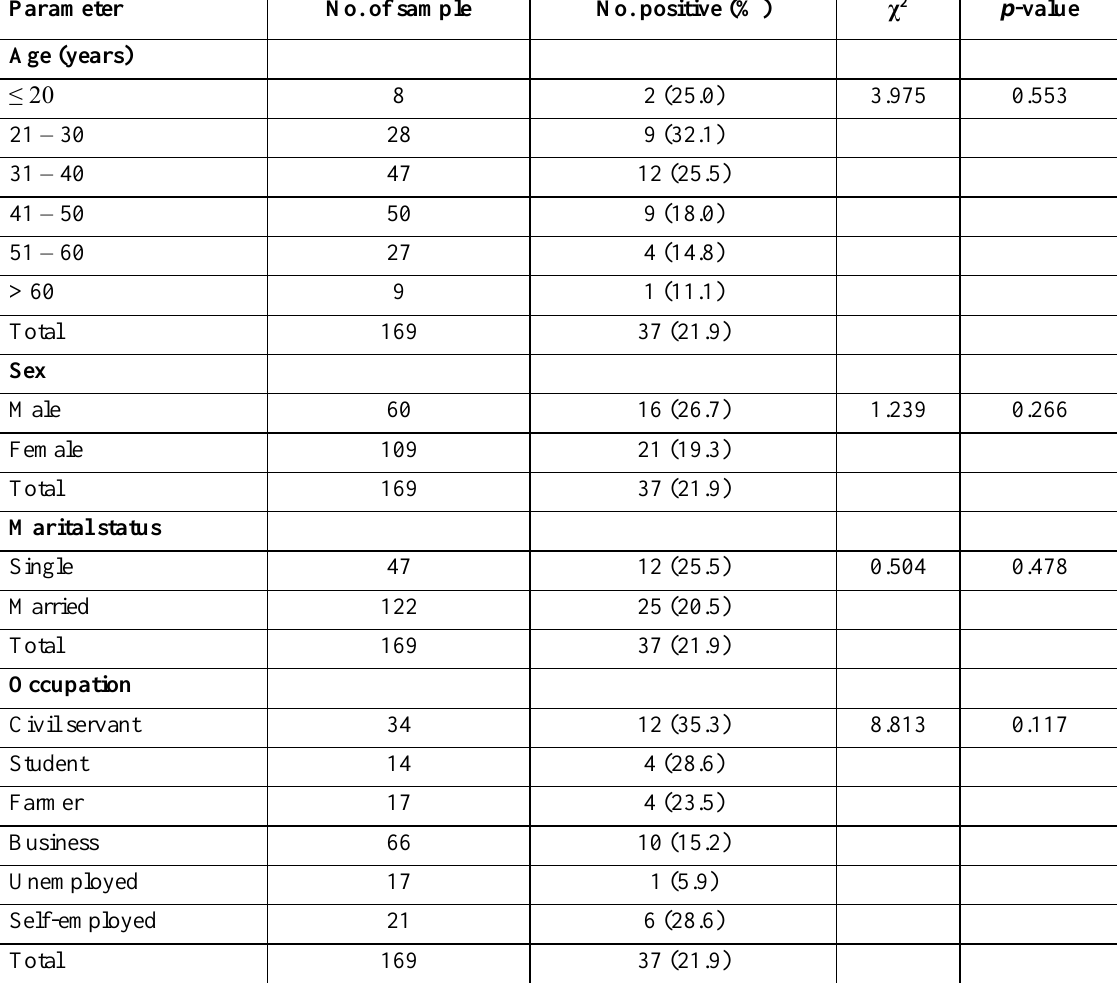
Table 1. Prevalence of intestinal helminths according to socio-demographic factors of HIV patients attending Faith Alive Foundation,